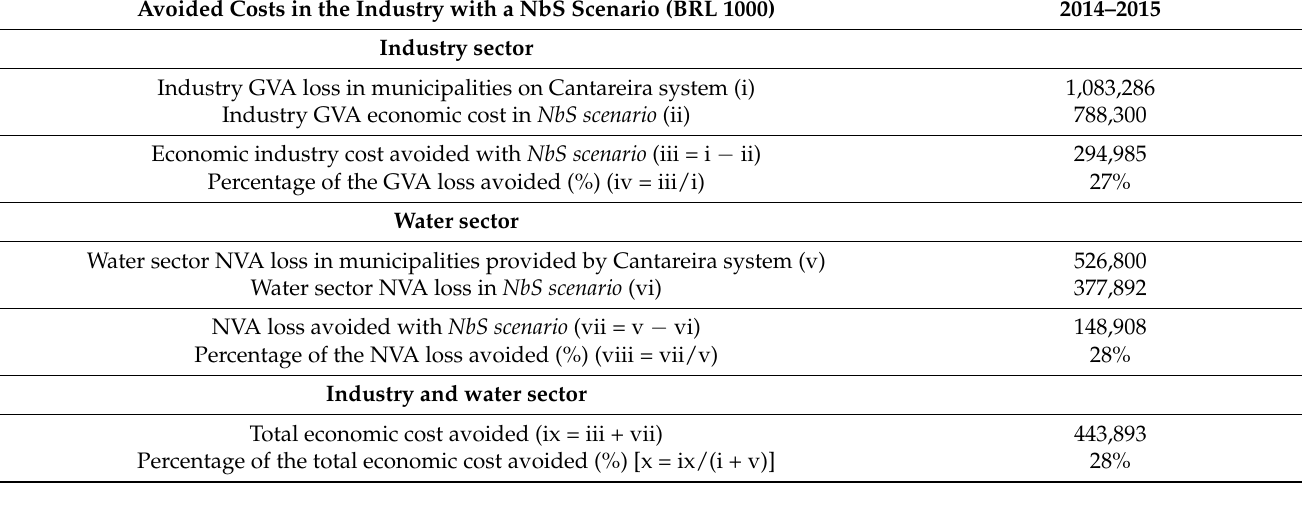
Table 7. Industry and water sector costs avoided in the NbS scenario (BRL 1000).